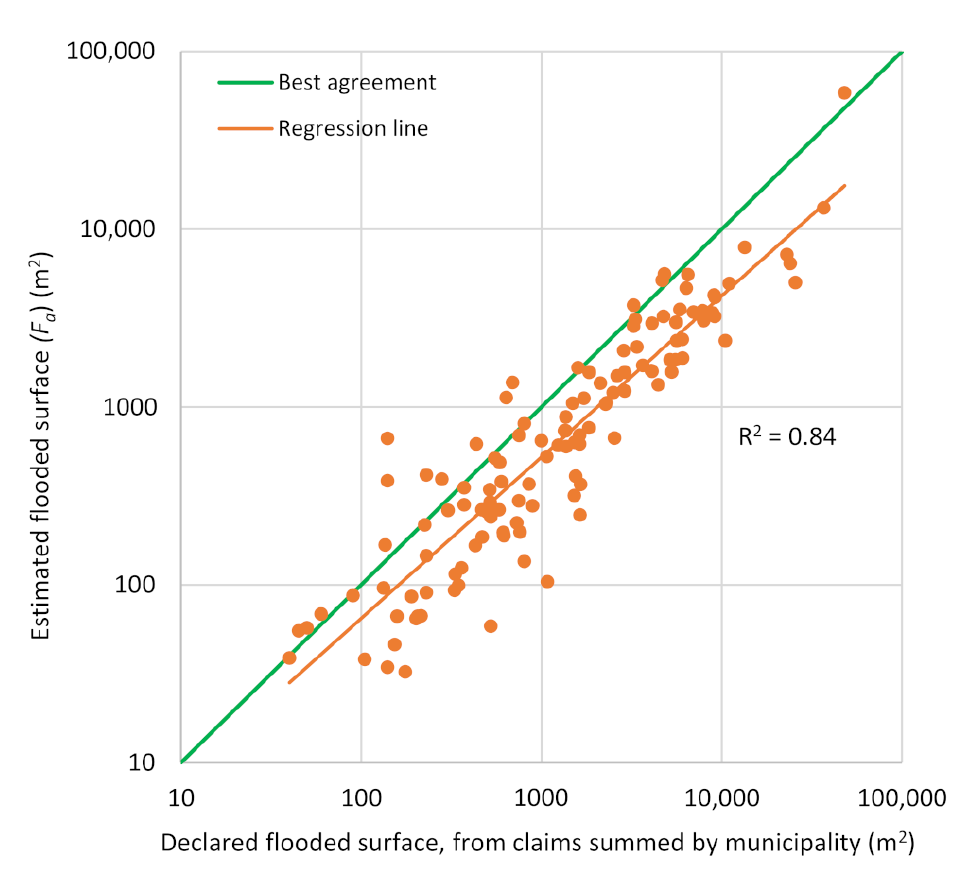
Figure 6. Estimated flooded surface vs. total declared surfaces derived from claims per municipality. The green line represents the best fit. The orange line represents the data regression line, and its R 2 indicates good data